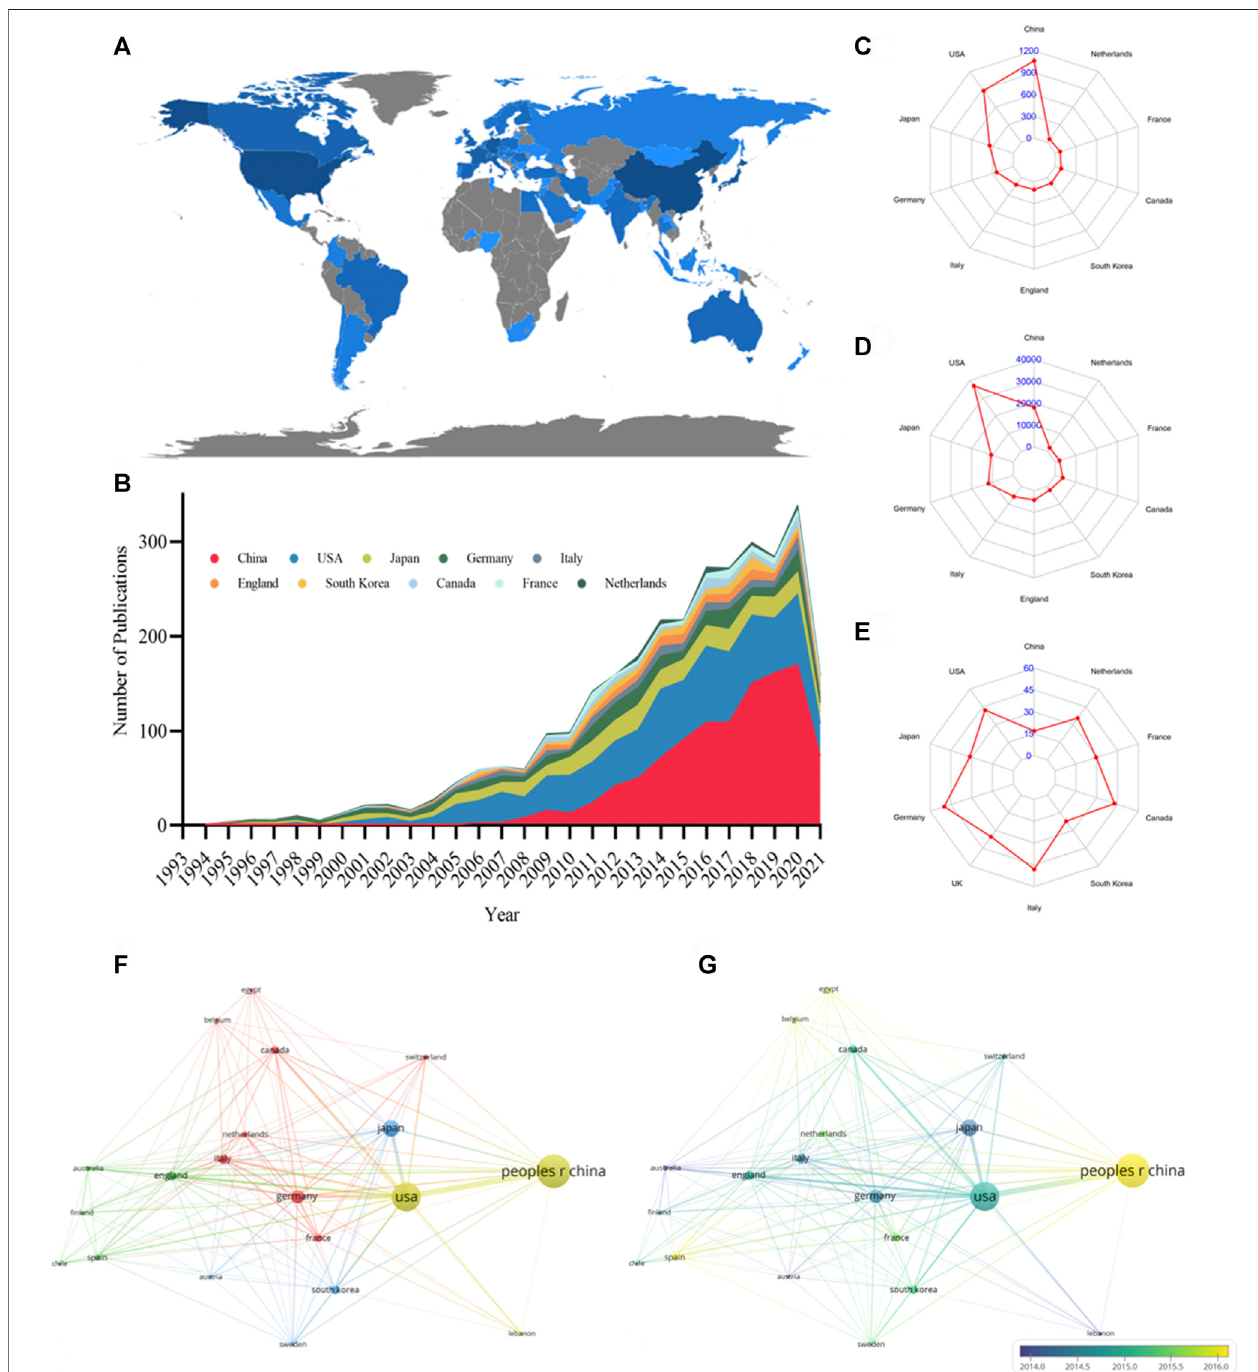
FIGURE 2 | Leading countries in podocyte injury research. (A) Geographical distribution of global output; (B) Annual output trend of the top 10 productive countries; (C) Radar map of the top 10 productive countries; (D) Radar map of TGCS of the top 10 productive countries; (E) Radar map of average cited of the top 10 productive countries; (F) Visual cluster analysis of cooperation among countries; (G) Timeline visualization of cooperation among countries.